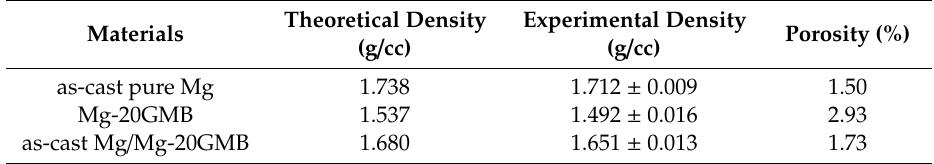
Table 1. Results of density and porosity measurements of monolithic and Mg / Mg-20GMB hybrid